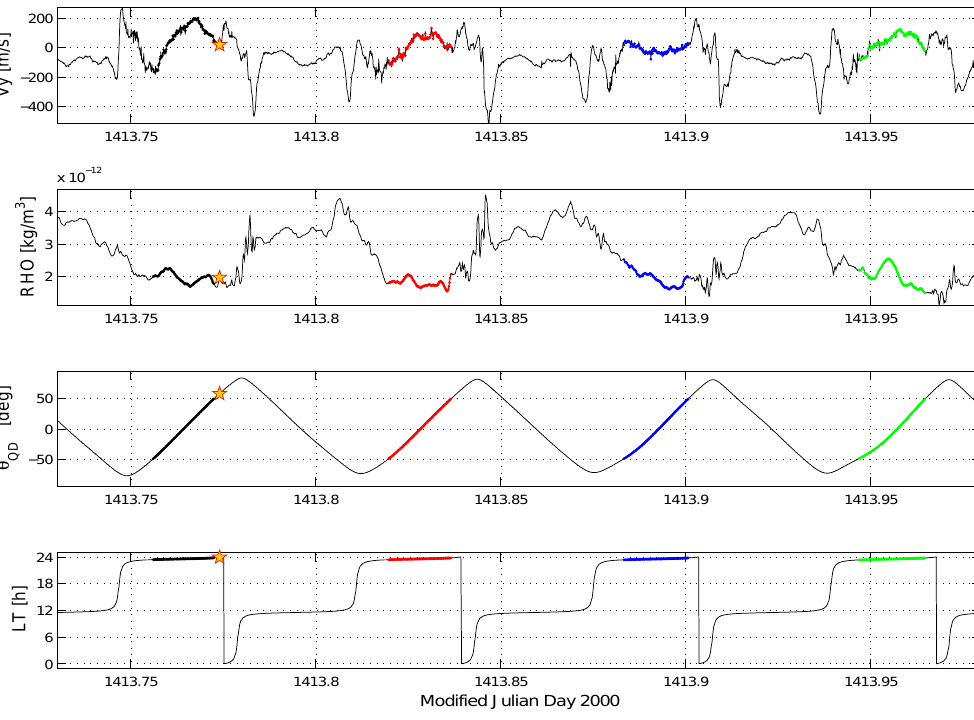
Fig. 1. Example of thermospheric density and wind variations along subsequent orbits before and after a substorm onset. The substorm onset T 0 takes place on 14 November 2003 at 18:34:29UT. It is marked by an asterisk on the curves. Top frame: zonal wind v y ; second frame: mass density; third frame: Quasi-Dipole latitude; bottom frame: MLT. The orbit sections used for the superposed analysis (equatorial profiles) are marked with black, red, blue, and green colors for the passes before, first, second, third pass after T 0 , respectively.